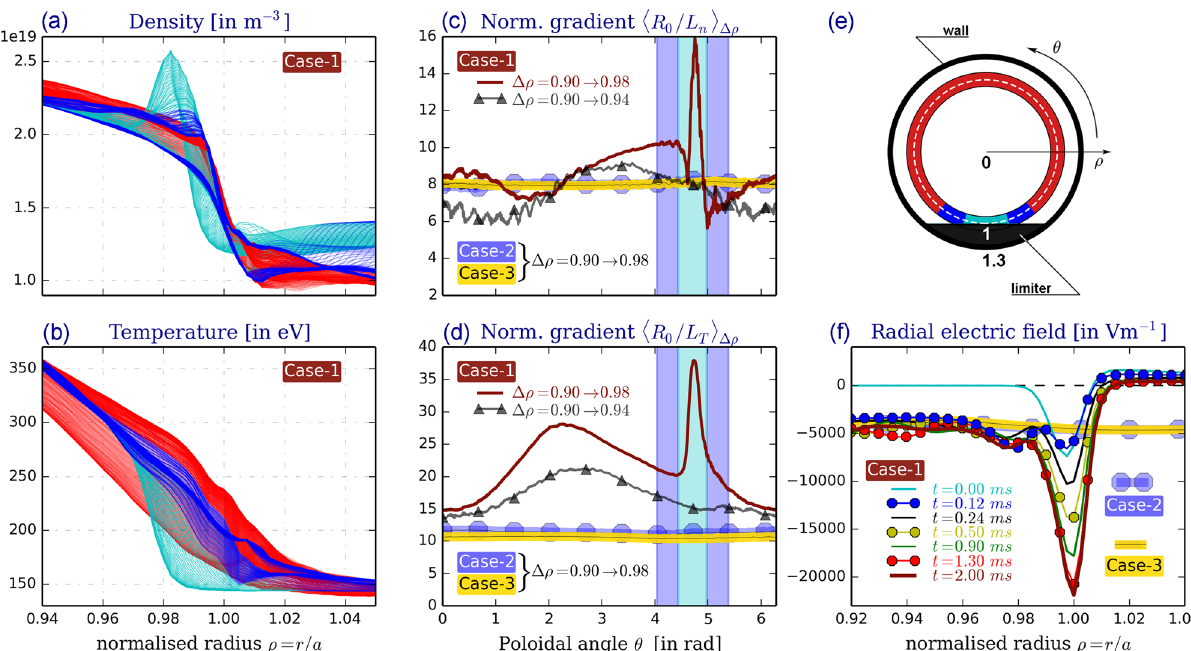
Fig. 2 A novel source of free energy arises from spontaneous symmetry breaking at the plasma-boundary interface. The radial pro fi les (along ρ ) of density ( a ), temperature ( b ) and the poloidal pro fi les (along θ ) of their respective normalised gradients ( c , d ) are colour-coded with poloidal proximity to the limiter ( e ). Thecyan [resp.dark blueand red] pro fi les in a , b represent the radial pro fi les atdifferent poloidal angles in the cyan [resp. darkblue and red] area of e . The poloidal pro fi les of radially averaged normalised gradients are shown in c , d . The solid red [resp. grey triangles] line is radially averaged over interval 0.90 ≤ r / a ≤ 0.98 (resp. over 0.90 ≤ r / a ≤ 0.94). Similarly, the cyan [resp. dark blue] vertical shades correspond to the cyan [resp. dark blue] area of e . Hot plasma particles rapidly stream towards the limiter along fi eld lines as well as through the action of vertical B × ∇ B magnetic drift (here pointing towards the limiter). This dynamics leads in Case-1 to the onset and sustainment of an over-dense poloidal density shelf ( a , c ) near the limiter as well as a localised temperature gradient ( b , d ) and a radial electric fi eld well, poloidally averaged ( f ), absent in poloidally homogeneous Cases 2 and 3 (thick dotted light purple and thick solid yellow respectively). This poloidal anisotropy is especially signi fi cant within 5% of the separatrix, as seen through radial averaging 〈 ⋅ 〉 Δ ρ of equilibrium mean gradients ( c , d ). Gradient anisotropy decreases in magnitude in the near SOL and poloidally farther from the limiter. Large and anisotropic equilibrium mean gradients in the limited con fi guration result in locally-enhanced free energy sources for the turbulence in the outermost 5% layer of the con fi ned edge. Inversely, Case-2 and Case-3 display uniform and moderate mean gradients, shown in thick yellow and dotted